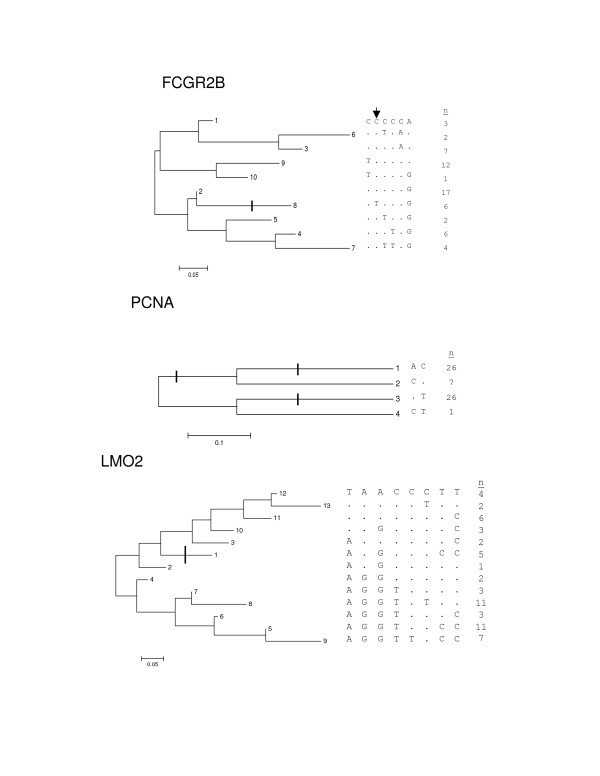
Haplotype phylogenies and significant haplotype partitions at FCGR2B, PCNA and LMO2. Haplotype phylogenies are represented together with the SNP allele configuration and the count of haplotypes in the sample. Statistically significant haplotype partitions in the phylogeny are indicated by a vertical or horizontal bar, while an arrow indicates a SNP that exhibits significant association via regression analysis. The haplotypes at FCGR2B, LMO2 and PCNA were constructed using the following SNPs: rs12145988, rs17412751, rs922087, rs2298020, rs1674761, rs844; rs17352 and rs25406; and rs3740616, rs3740617, rs2273797, rs2038602, rs9282776, rs3781577, rs3758640, rs3758641.